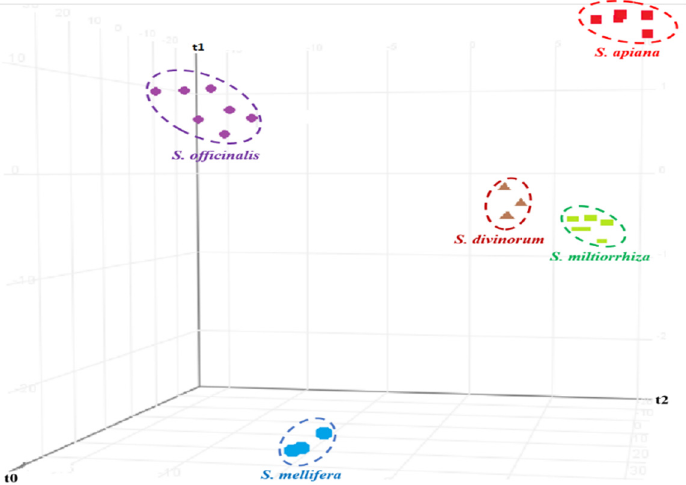
Figure 3 . Score plot of the PLS-DA model constructed based on GC/Q-ToF data for the authenticated Salvia samples from five different species.